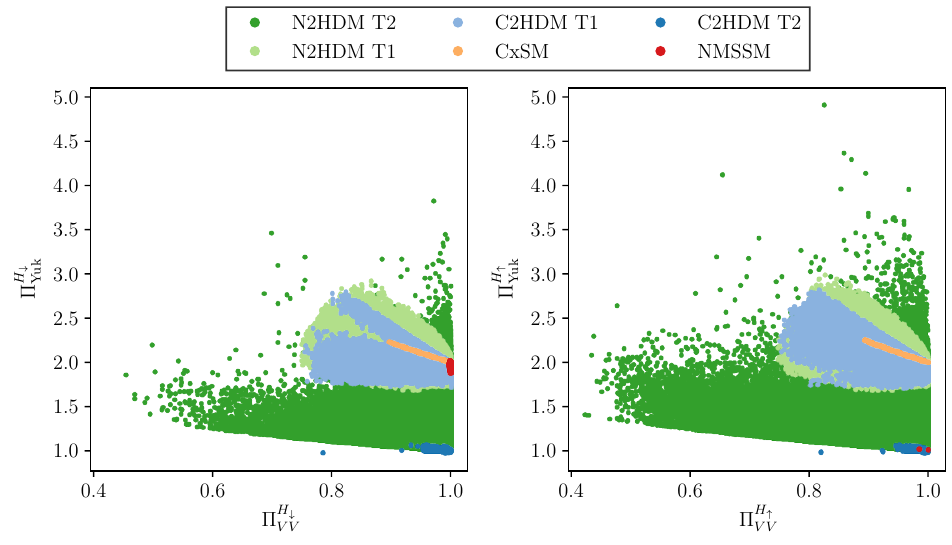
Figure 15 . Partial Yukawa sum (cid:5) (2)